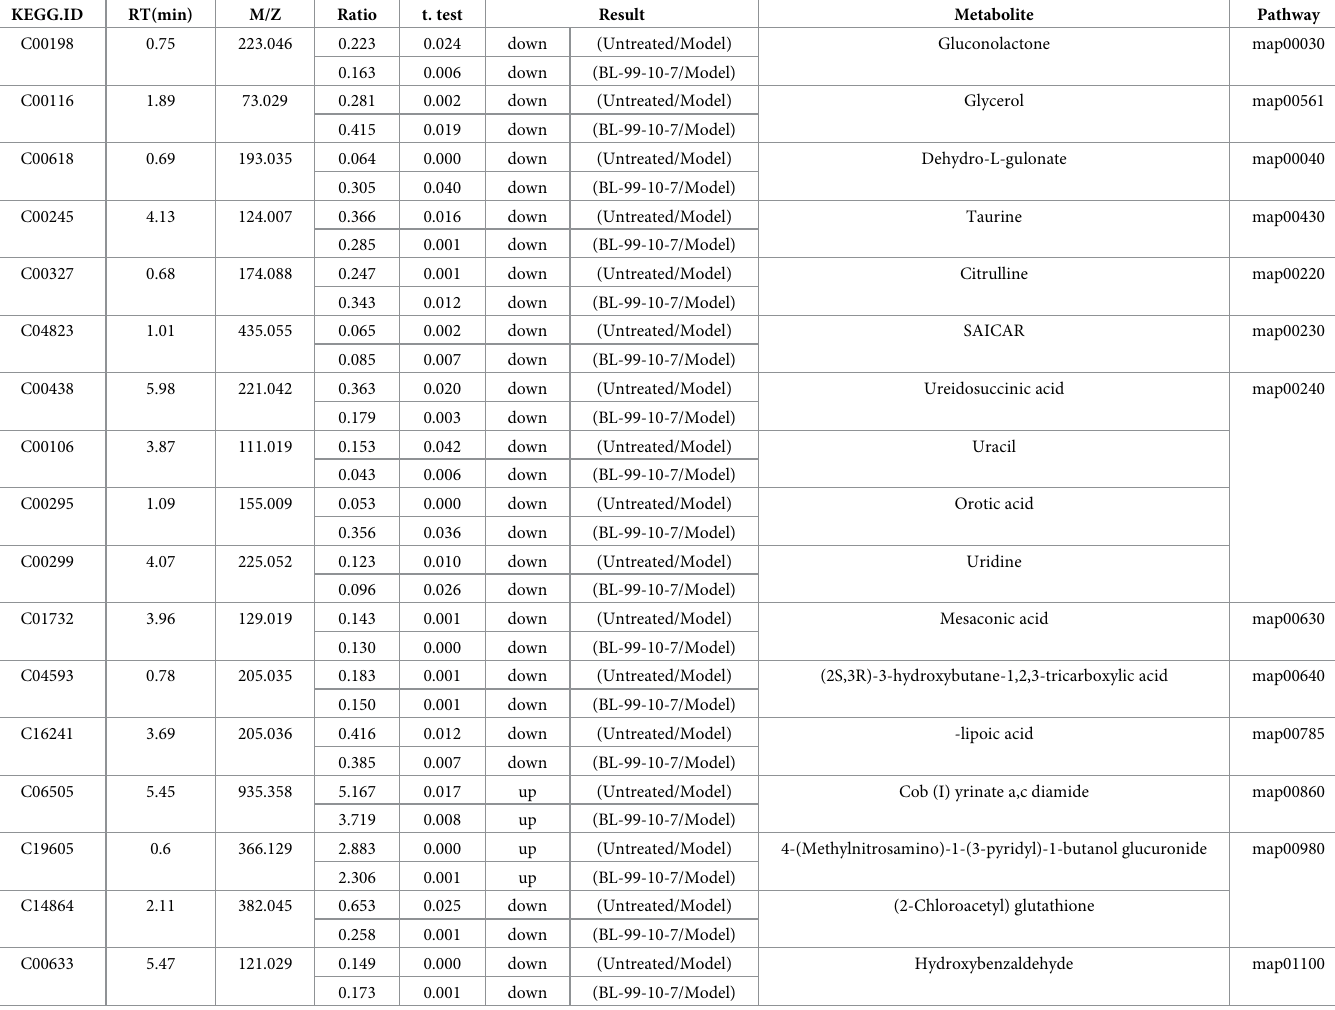
Table 1. Negative-ion metabolites in the intestinal function disorder zebrafish after B . lactis BL-99 treatment. KEGG.ID